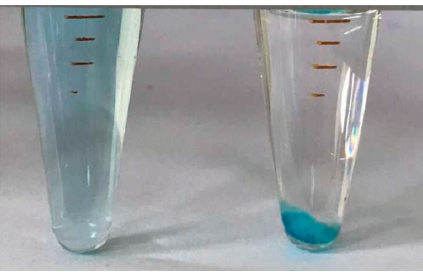
Figure 4: The ionic liquid at extraction stage and separation stage.